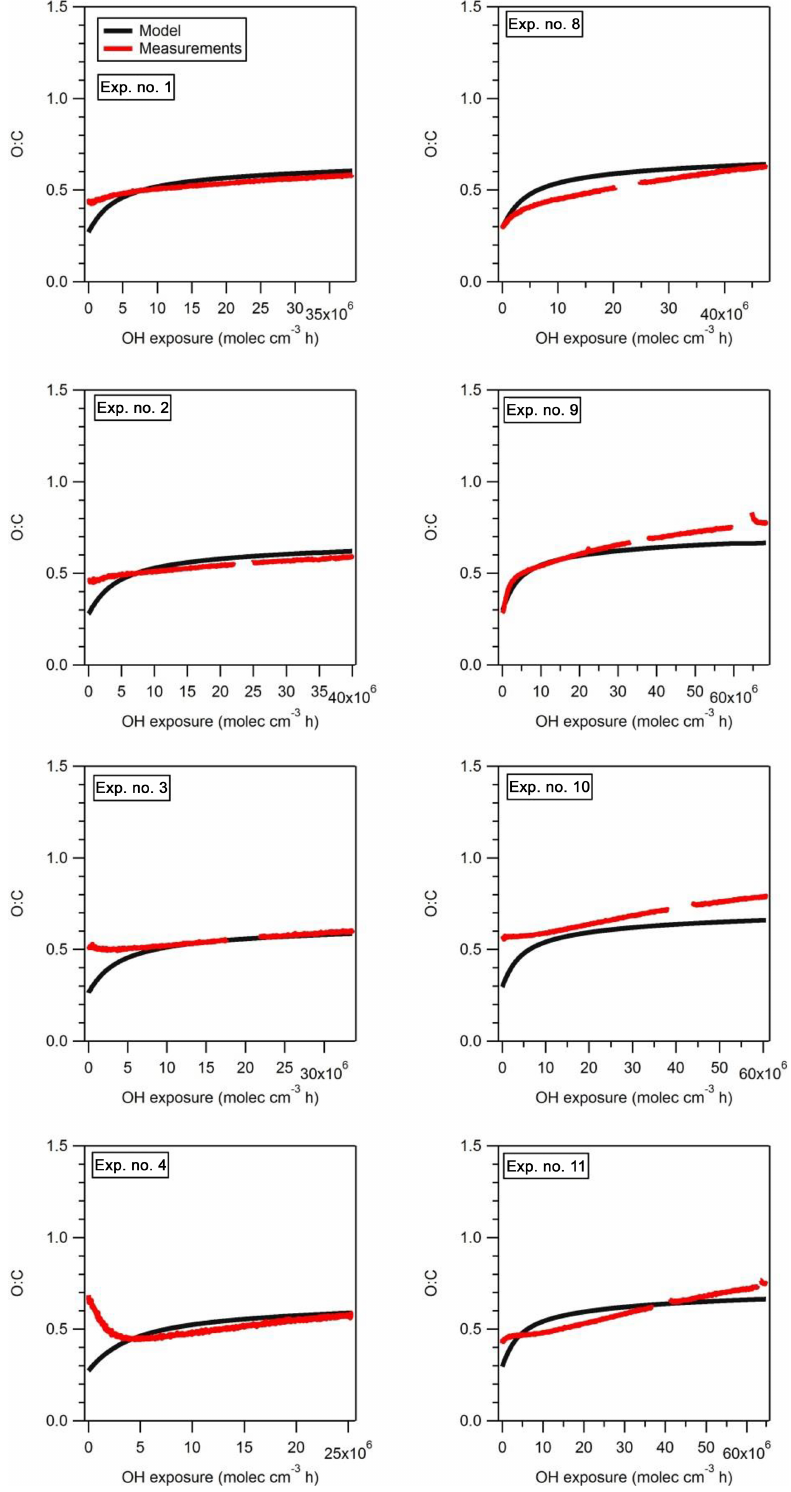
Figure 5. Modelled (black lines) and observed (red lines) O:C ratio for low-temperature experiments (left side) and high-temperature experiments (right